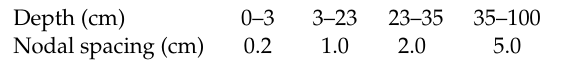
Table 2. Nodal spacing in the simulation domain.